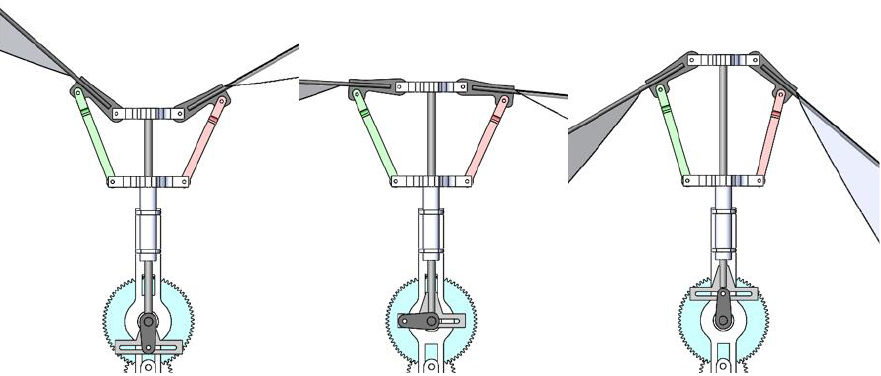
Figure 8. Changing parts of the mechanism can adjust the related flapping parameters.